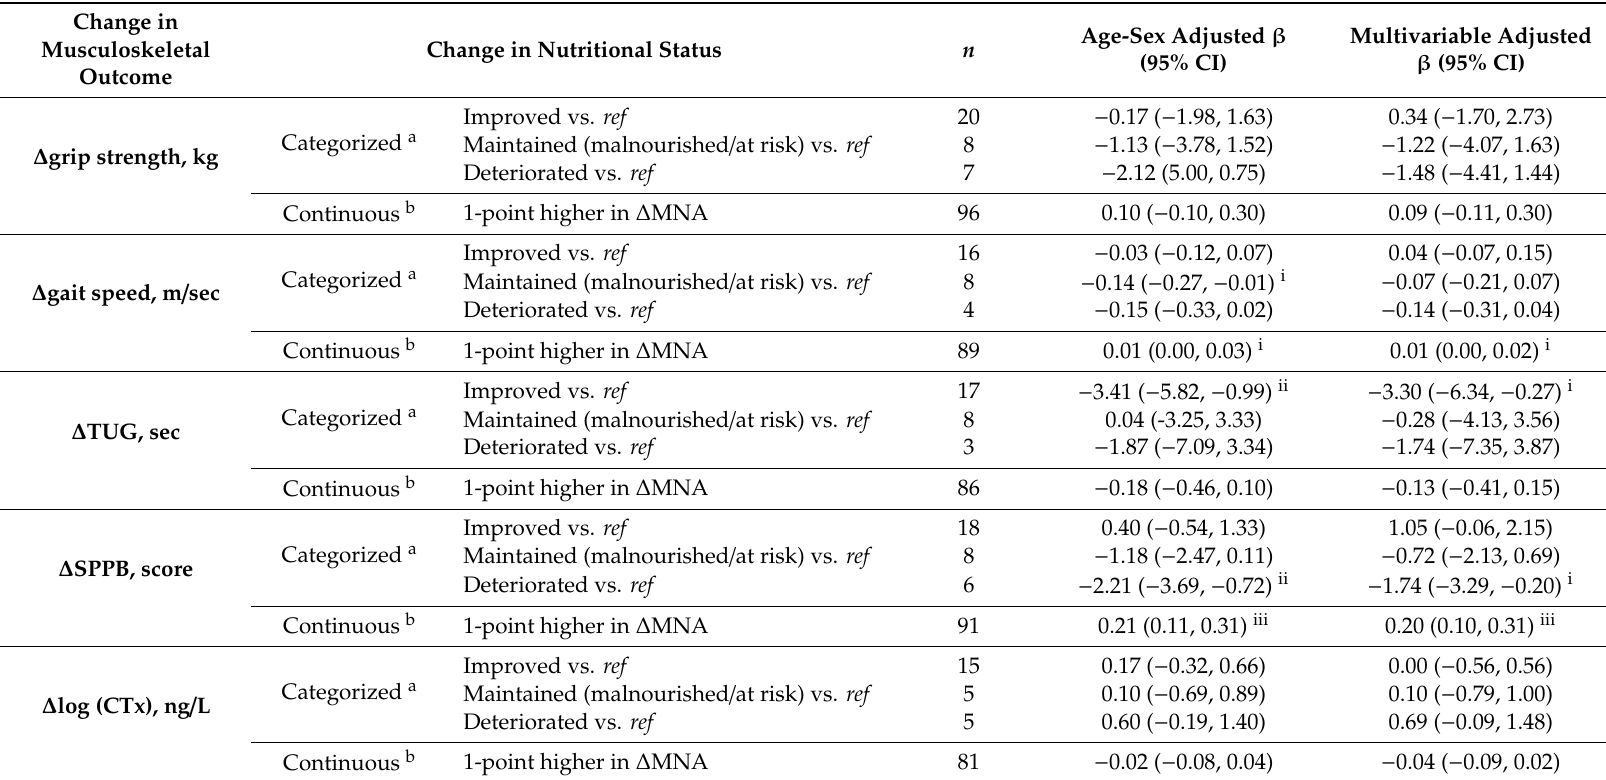
Table 3. Results of multiple linear regression analyses testing the association between changes in nutritional status and musculoskeletal outcomes. Change